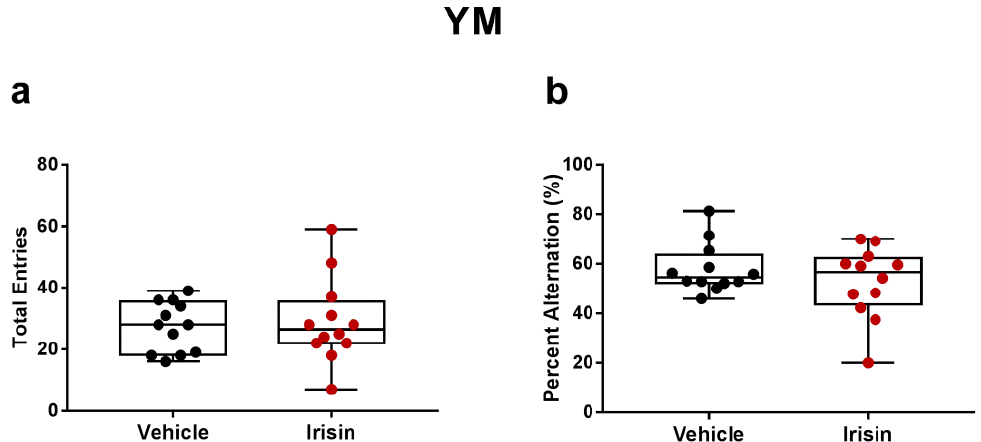
Figure 4. Effect of short-term systemic administration of irisin on the total entries ( a ) and in the percent alternation ( b ) in the YM. Shapiro–Wilk test was followed by unpaired two-tailed Student’s t -test. Data are presented as box-and-whisker with median and interquartile ranges, from max to min, with all data points shown. n = 12 vehicle-treated mice and n = 12 irisin-treated mice. Table 2. Summary of the statistical analysis by two-way ANOVA for the factors: treatment, sex, and treatment x